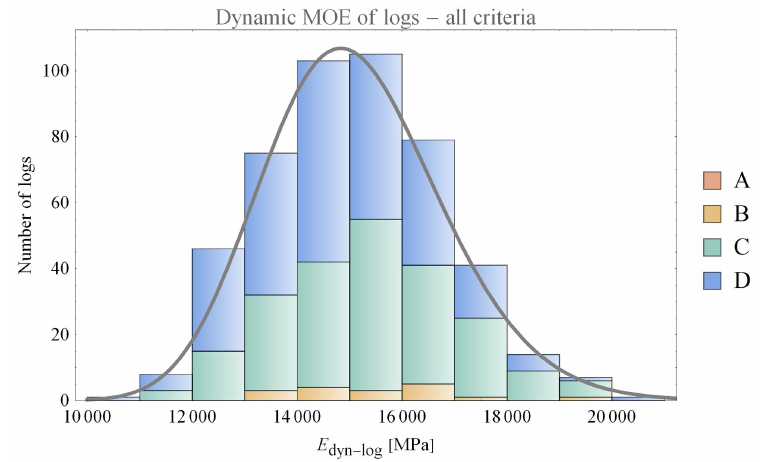
Figure 8. Dynamic moduli measured on logs with the PDF function (log-normal) per visual grad- ing class.